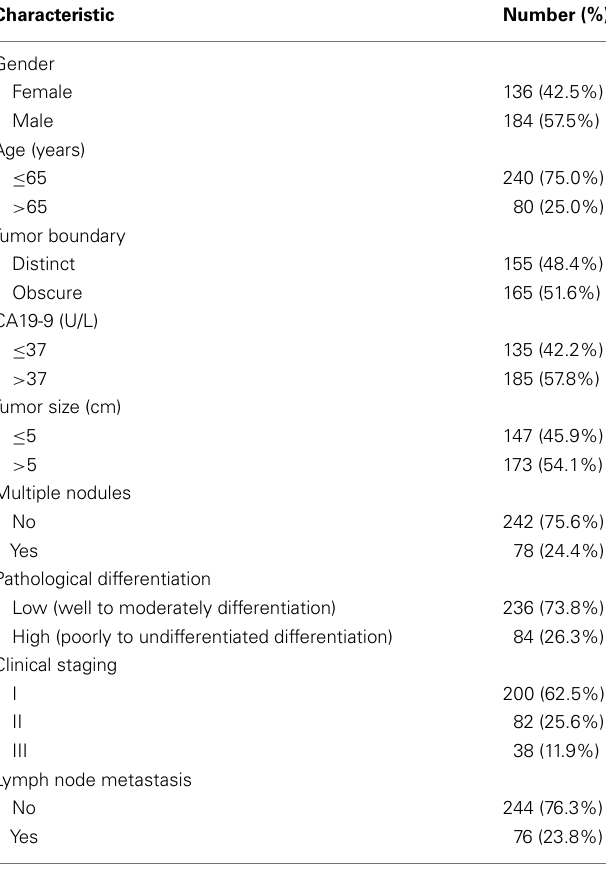
Table 1 | Patient characteristics. Table 2 | Results of the univariate analysis of factors associated with